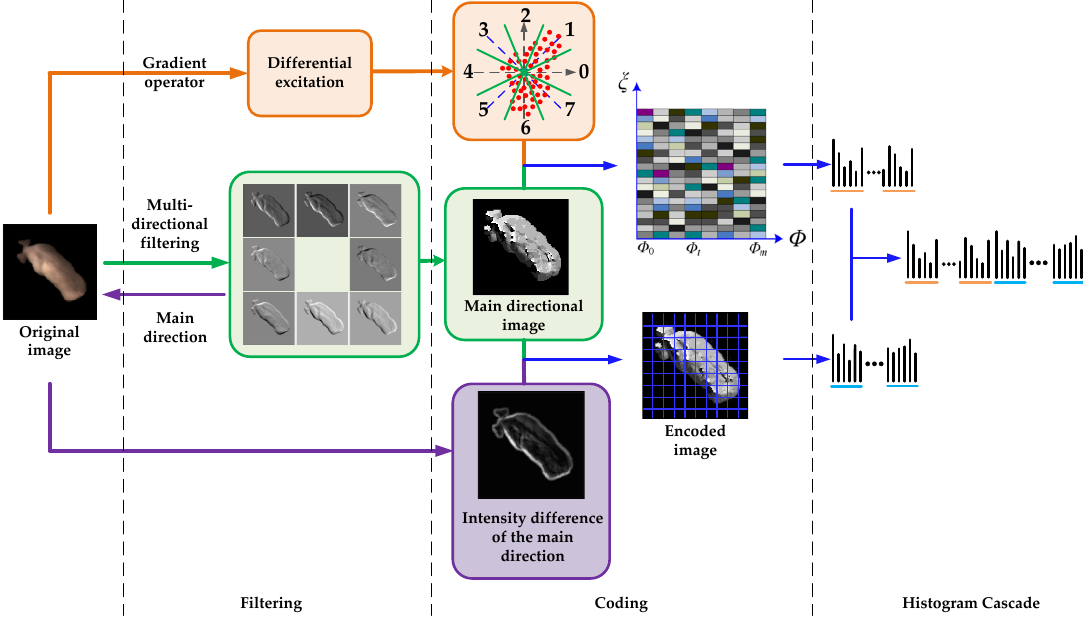
Figure 4. Illustration of the computation of the proposed Weber texture local descriptor (WTLD).